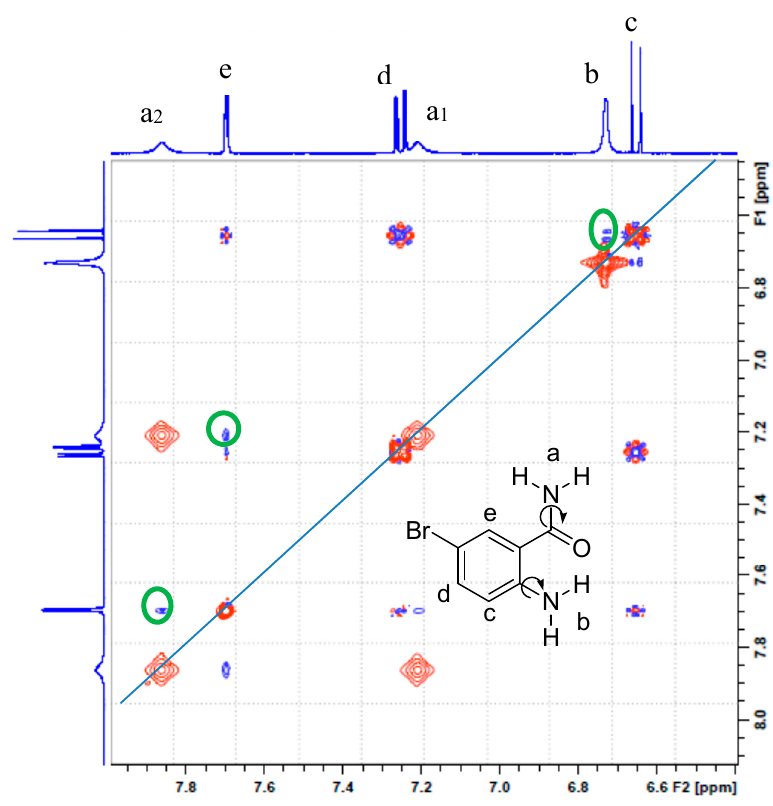
Figure 1. The 2D NOESY spectrum of ABB in DMSO- d 6 at 400 MHz.